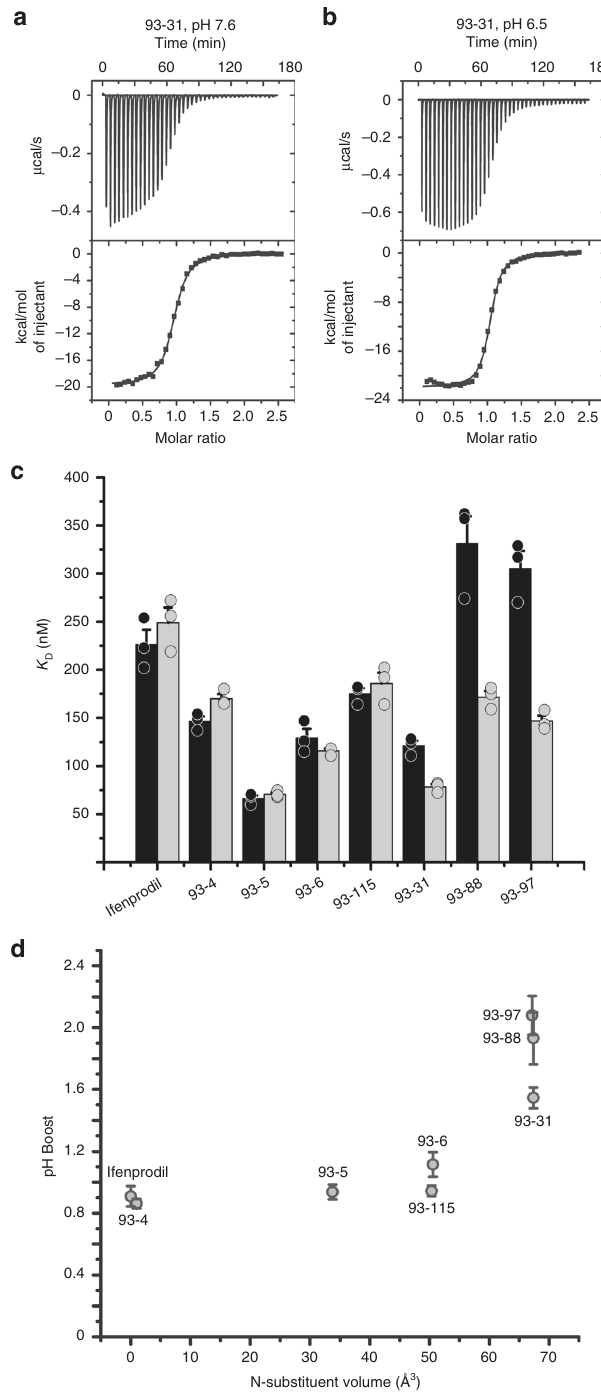
Fig. 2 ITC titrations of the GluN1/GluN2B ATD with different ligands at pH 7.6 and 6.5. Representative ITC isotherms of the isolated GluN1-GluN2B ATD titrated with 93-31 at pH 7.6 ( a ) and 6.5 ( b ). The average dissociation constant ( K D ) for 93-31 at pH 7.6 was 121±5.1nM, which drops to 78.4±2.97nM at pH 6.5 (Table 1). c Dissociation constants for various 93-series ligands at pH 7.6 (black bar) and pH 6.5 (gray bar). d The ratio of the K D at pH 7.6 to the K D at 6.5 (pH-boost) is shown as a function of N-substituent volume. For all panels, error bars represent mean±S.E.M. All experiments were performed in